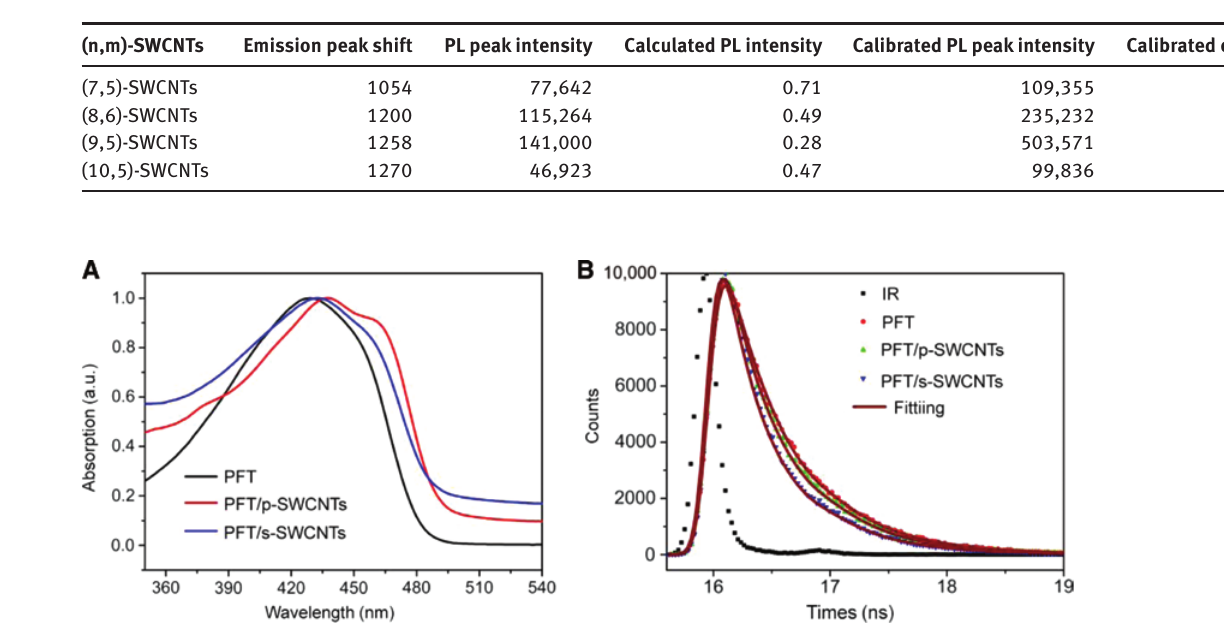
Figure 3: UV-vis absorption spectra and PLE lifetimes. (A) Normalized UV-vis absorption spectra for PFT, PFT/s-SWCNTs, PFT/p-SWCNTs in a toluene solution. (B) PLE lifetimes of PFT polymers in pure PFT, PFT/s-SWCNTs, and PFT/p-SWCNTs in a toluene solution (excitation wavelength at 430 nm, emission wavelength at 505 nm).